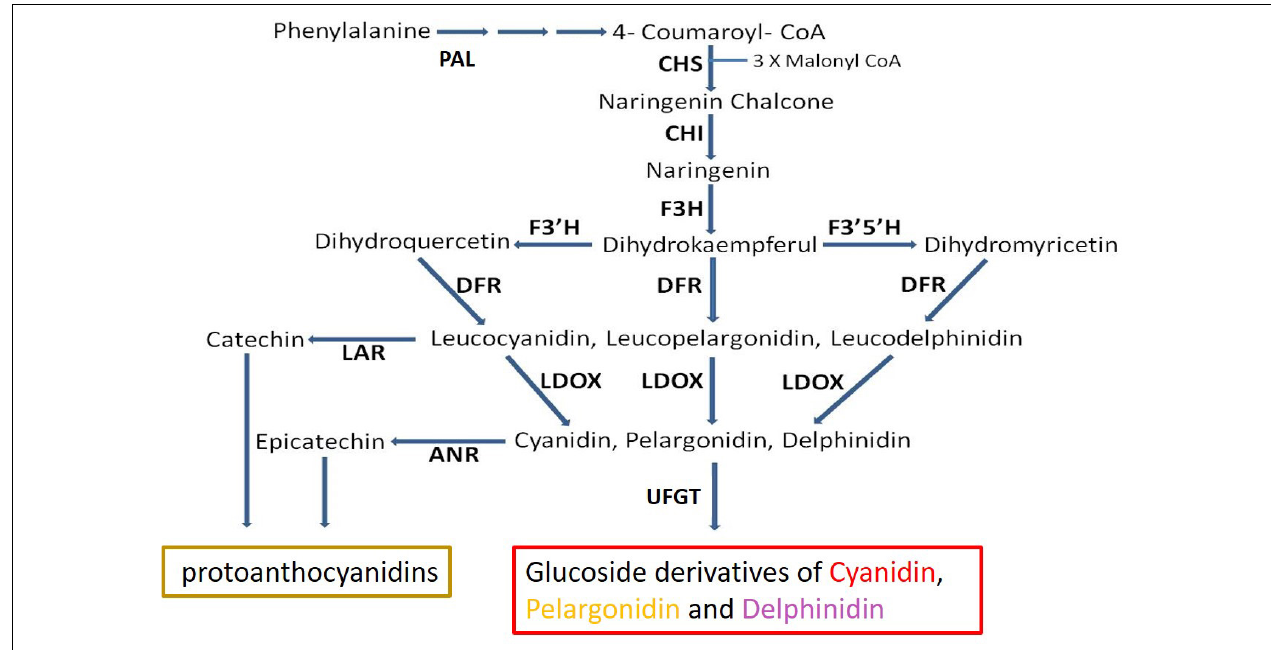
FIGURE 1 | Schematic representation of the flavonoid-biosynthesis of anthocyanins and proanthocyanidins. Enzyme name abbreviations are as follows: PAL, phenylalanine ammonia-lyase; CHS, chalcone synthase; CHI, chalcone isomerase; F3H, flavanone 3-hydroxylase; F3 (cid:48) H, flavonoid 3 (cid:48) -hydroxylase; F3 (cid:48) 5 (cid:48) H, flavonoid 3 (cid:48) ,5 (cid:48) -hydroxylase; DFR, dihydroflavonol reductase; LDOX, leucoanthocyanidin oxidase; ANS, anthocyanidin synthase; LAR, leucoanthocyanidin reductase; ANR, anthocyanidin reductase; UFGT, UDP glucose:flavonoid 3- O -glucosyltransferase. Adapted from Ben-Simhon et al.